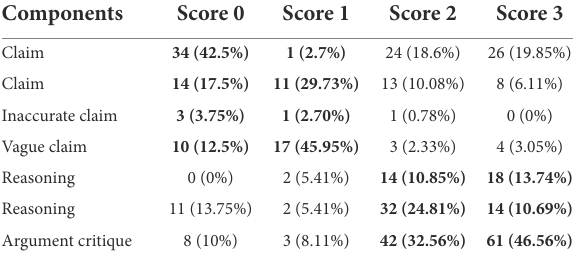
TABLE 5 Misscores by component of MA rubric for item